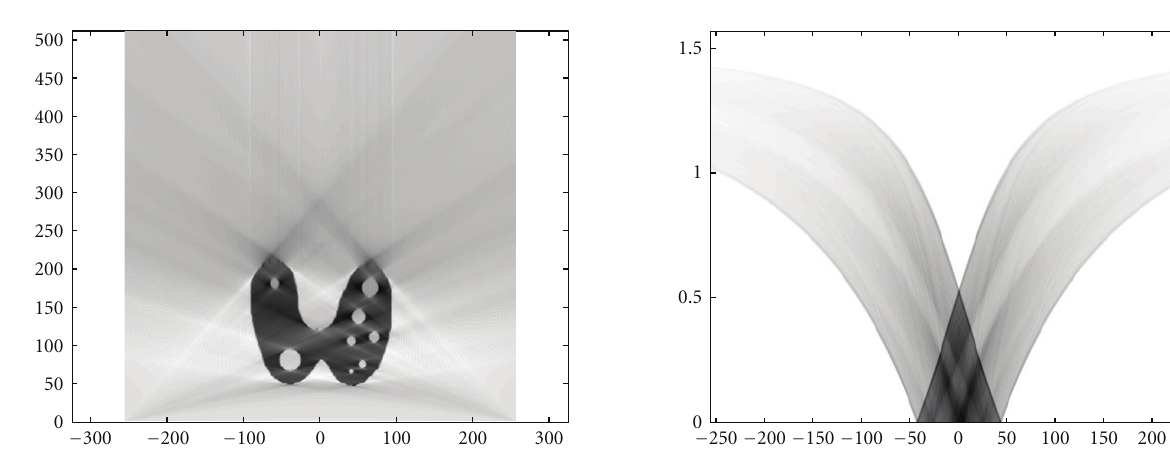
Figure 23: The T V transform of the Shepp-Logan image shown in Figure 19 with dω = 0 . 0025 rad.